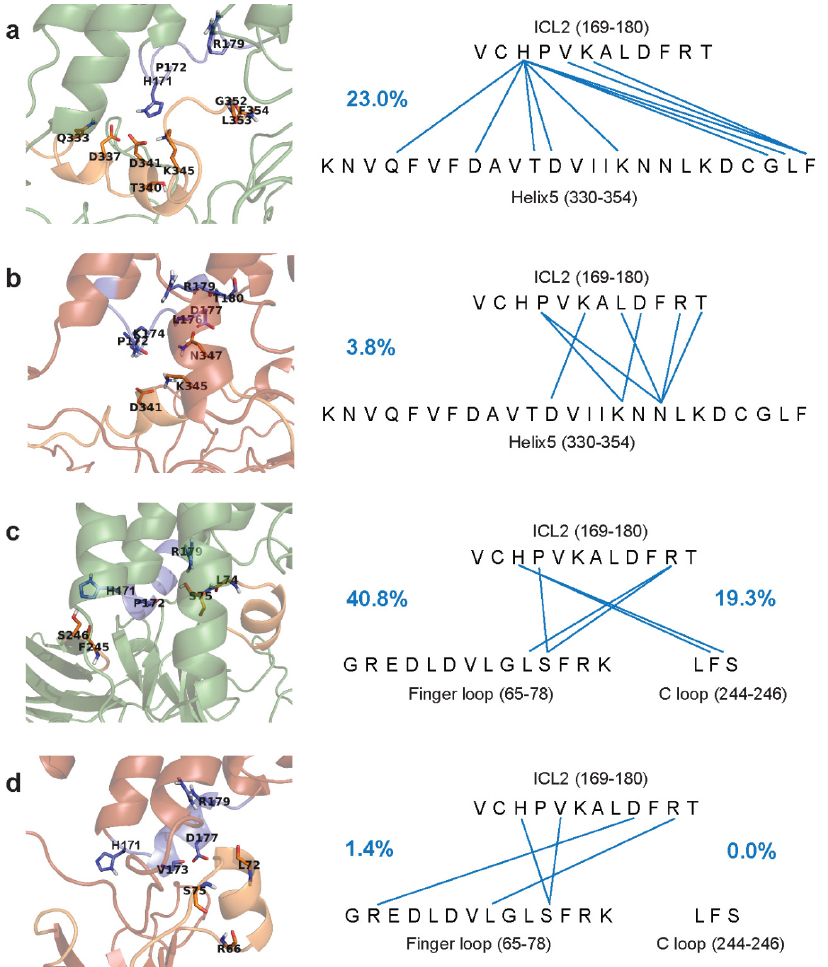
Figure 1. Frequency and donor and acceptor sites of intermolecular H-bonds between ICL2 of the MOP and the G i protein or beta-arrestin-2. Frequency of H-bonds are expressed as percentages of the total structural ensemble and indicated by blue numbers. ICL2 is shown as blue cartoon and sticks. Helix 5 of the G i α subunit and the finger- and C loops of beta- arrestin-2 are shown as orange cartoon and sticks. ( a ) Active receptor and the G i α subunit. ( b ) Inactive receptor and the G i α subunit. ( c ) Active receptor and beta-arrestin-2. ( d ) Inactive receptor and beta-arrestin-2.